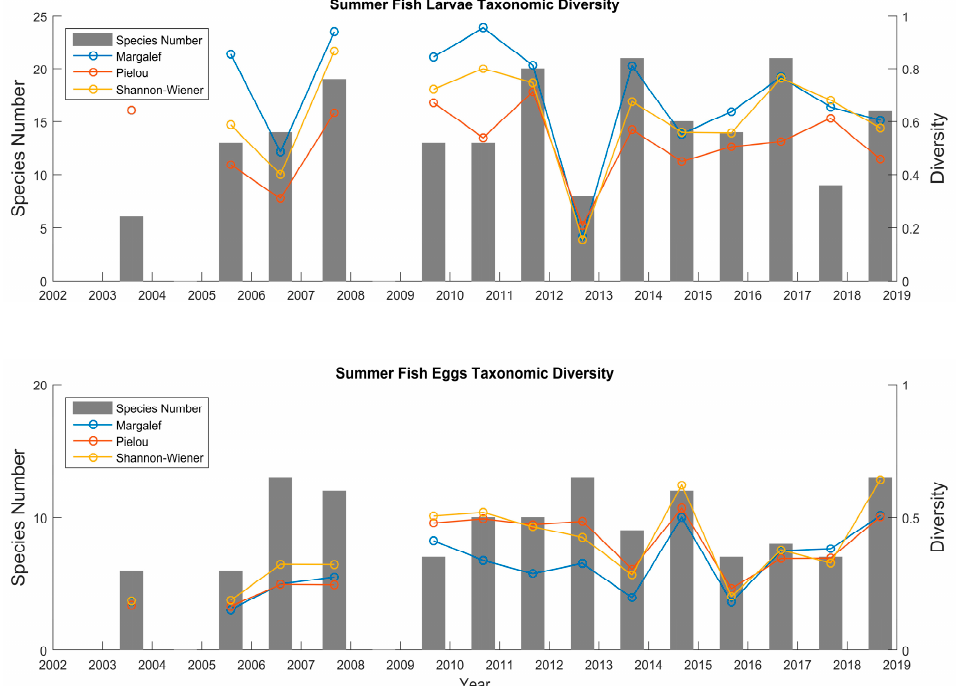
Figure 5. Spatially averaged species number and taxonomic diversity for the fish larvae and eggs from 2003 to 2018.